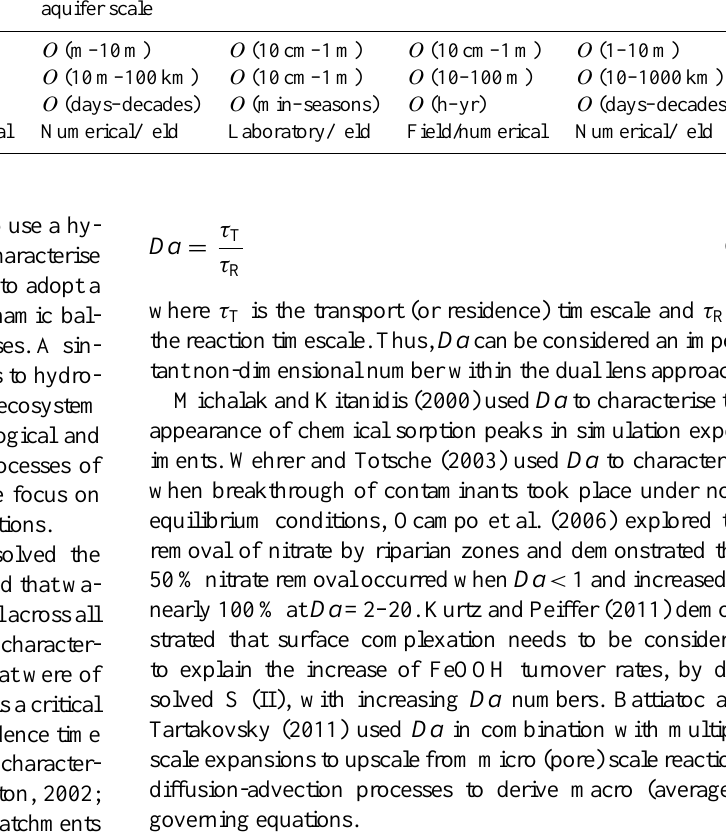
Table 1. Different preferred modes of investigation used for different scales of elements in hydrological systems. Soil pore